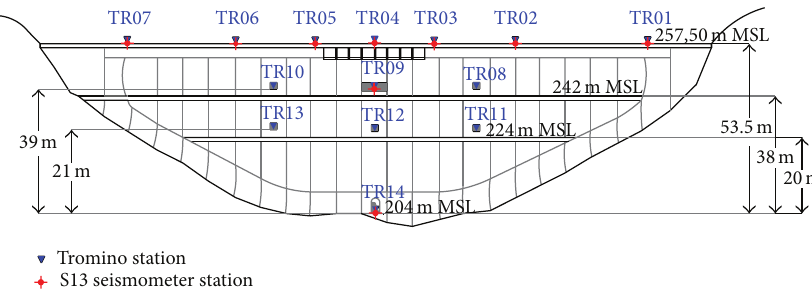
Figure 4: In-contact microtremor stations placed at different floors of Punta Gennarta Arch Dam, downstream side view (blue triangles indicate Tromino stations; red circles mark S13 stations).